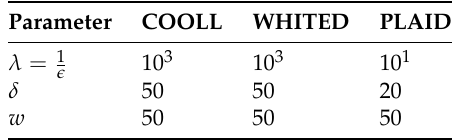
Table 1. Parameters used in experiment two.